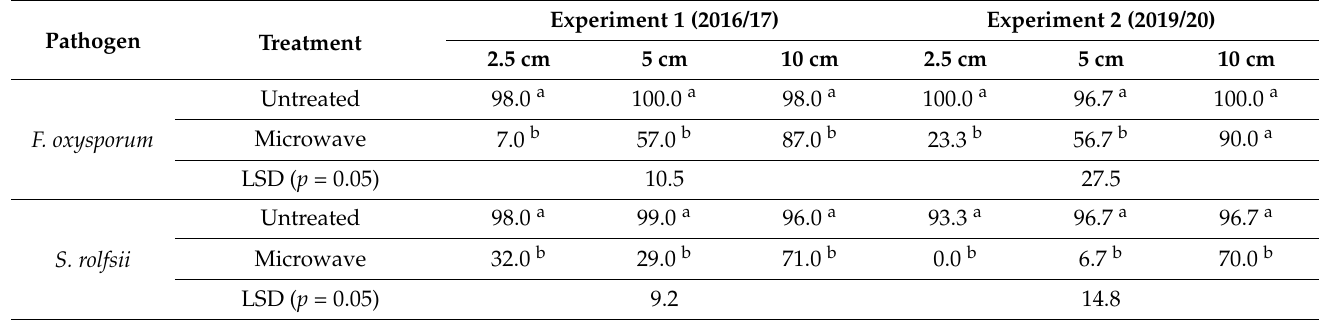
Viability (%) of inoculum of the strawberry pathogens Fusarium oxysporum and Sclerotium rolfsii buried at different soil depths following treatment with microwave in two field